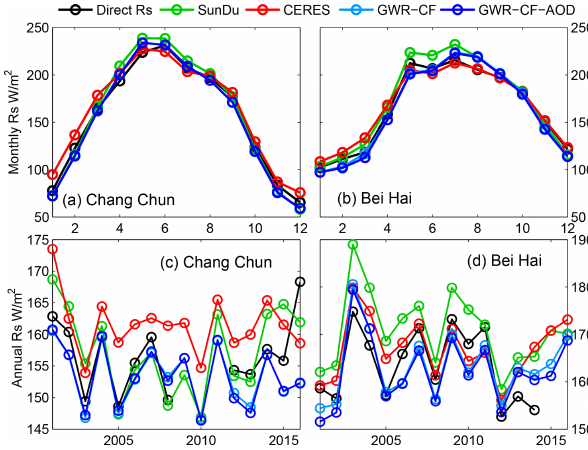
Figure 5. Seasonal and annual variations in R s at two sites: Changchun ( a, c , 43.87 ◦ N, 125.33 ◦ E) and Beihai ( b, d , 23.50 ◦ N, 99.72 ◦ E). SunDu R s is the SunDu-derived R s data, and GWR-CF R s is R s produced by the GWR method incorporating only the cloud fraction. GWR-CF-AOD is R s produced by the GWR method in- corporating cloud fraction and AOD. The multiyear mean of AOD from Changchun and Beihai is 0.49 and 0.70, respectively.